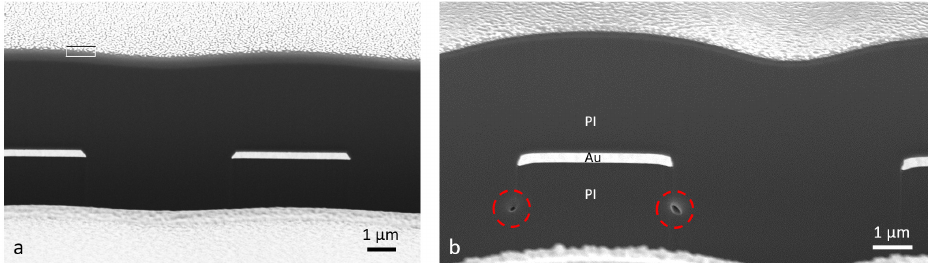
Figure 5. SEM images of the 5 µm polyimide/300 nm gold/5 µm polyimide cross-section: ( a ) 1 min oxygen RIE @ 25 W of the first polyimide layer; ( b ) 3 min oxygen RIE @ 25 W of the first polyimide layer. Voids are present at the PI/PI interface (red circles).